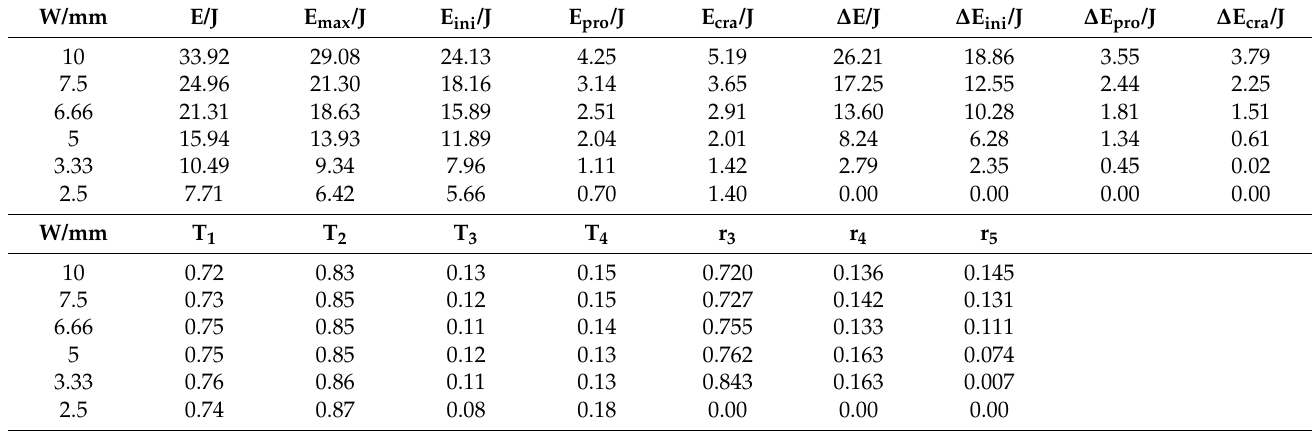
Table 8. Characteristic energies and corresponding ratios of samples with different